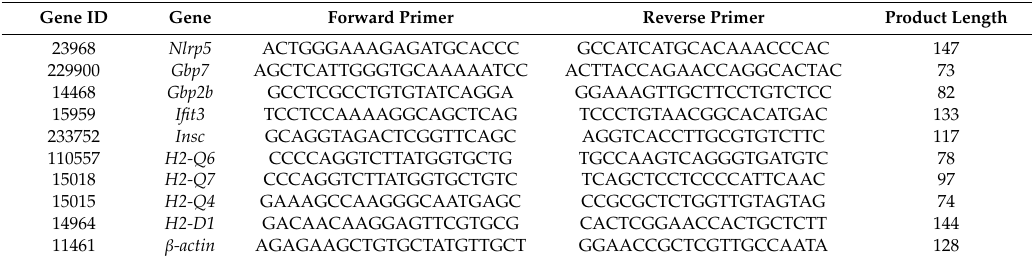
Table 1. Design of primers used for Quantitative Real-Time PCR Analysis (qRT-PCR)